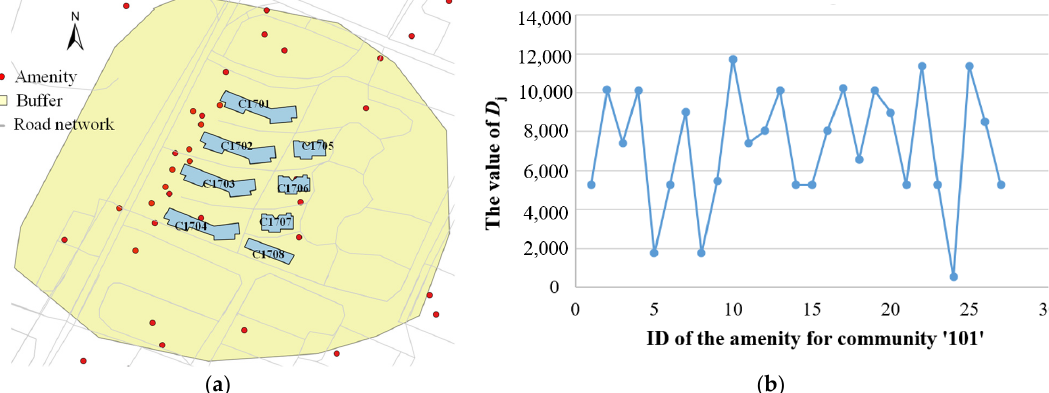
Figure 8. Accessibility measurement for the community ‘101’, ( a ) buffer construction; ( b ) population capacity of surrounding amenities.